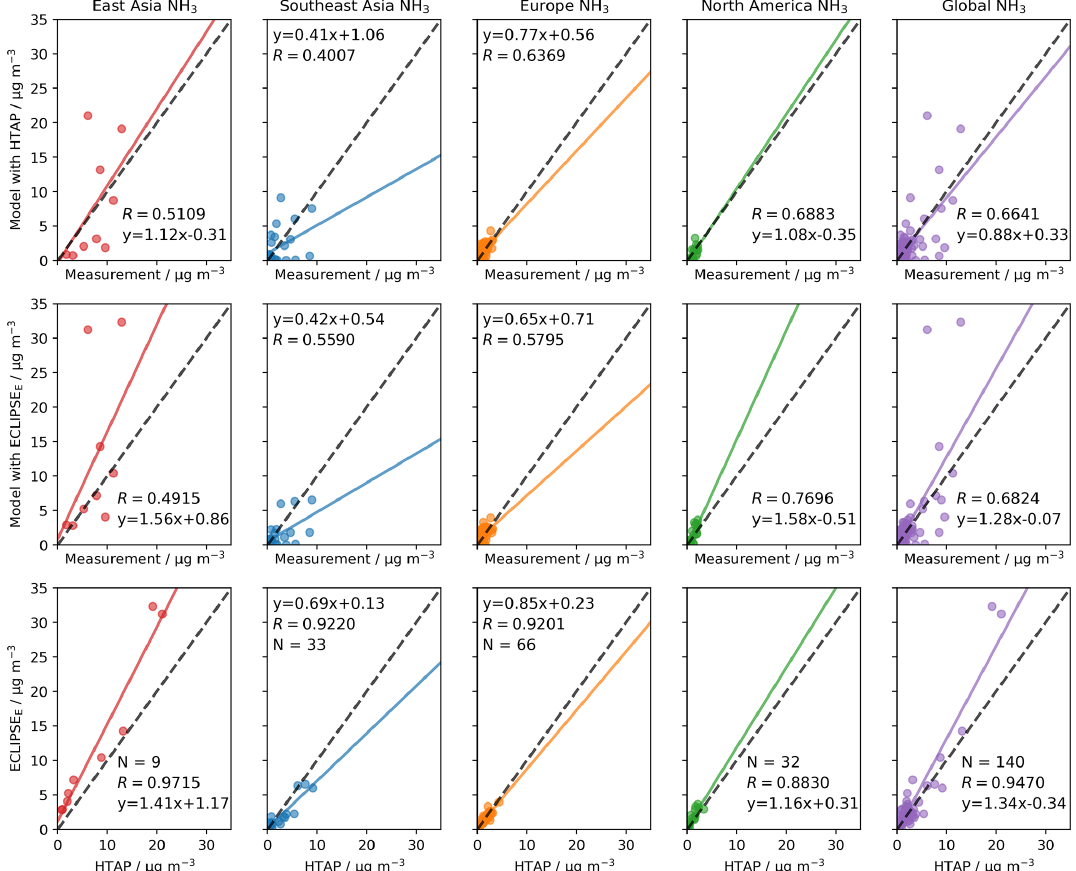
Figure 4. Comparisons of annual average surface concentrations of NH 3 for eight monitoring networks in 2010 – NNDMN from China as East Asia, EANET as Southeast Asia, NAMN and AGANet (UK) and EMEP/CCC plotted together here as Europe, and the EPA and AMoN (USA) and NAPS (Canada) plotted together here as North America – and for all networks combined (“global”). The upper row of plots is modelled versus measured values using the HTAP emission inventory. The middle row is modelled versus measured values using the ECLIPSE E emission inventory. The lower row is the modelled data for the two inventories plotted against each other for the same set of model grids that contain measurement sites. In each plot, N is the total number of scatter points, R is the Pearson correlation coefficient, the dashed black line is the 1 : 1 line, and the solid coloured line is the trend line corresponding to the equation